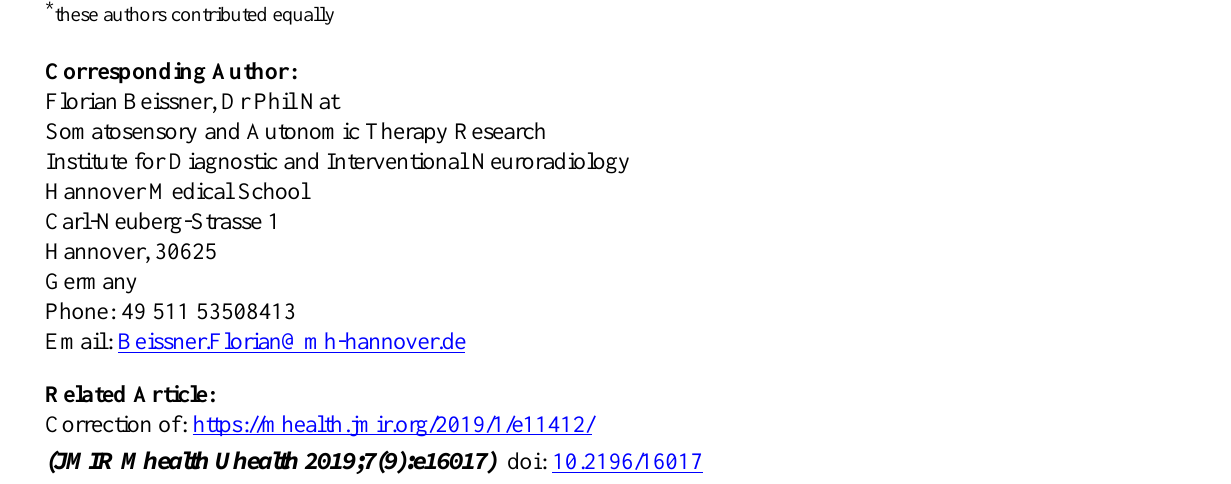
Figure Correction: Digital Pain Drawings Can Improve